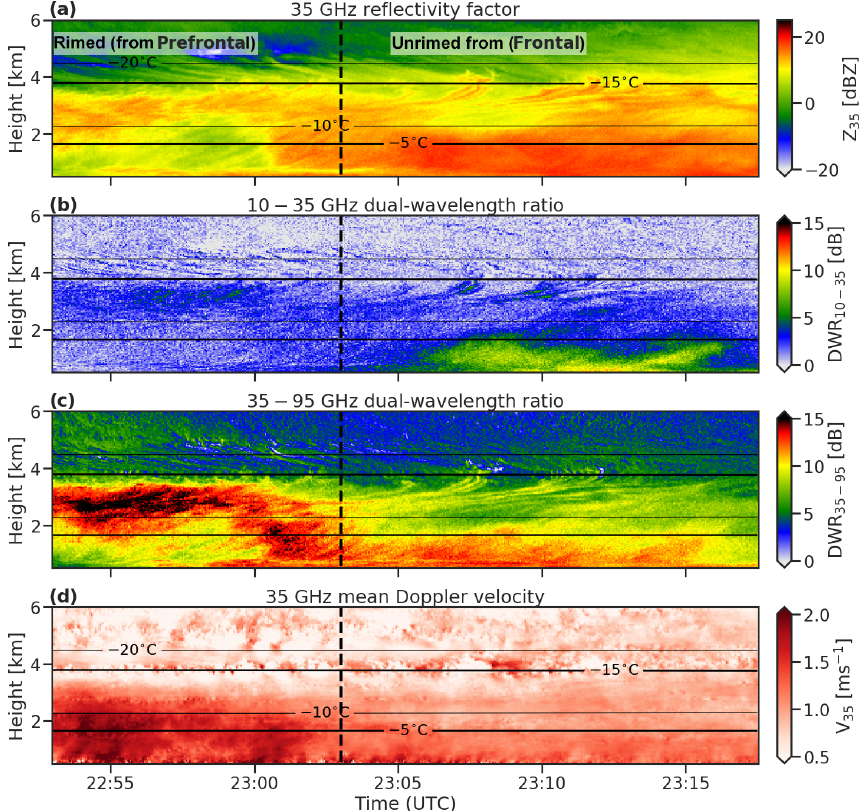
Figure 6. Triple-frequency Doppler radar measurements from the 21 February 2014 case study at Hyytiälä, Finland: (a) 35GHz radar reflectivity, (b) 10–35GHz dual-wavelength ratio, (c) 35–95GHz dual-wavelength ratio and (d) 35GHz mean Doppler velocity. Vertical dashed lines mark the transition between the heavily rimed and large aggregate snowfall regimes; solid lines are contours of temperature from ECMWF analysis.